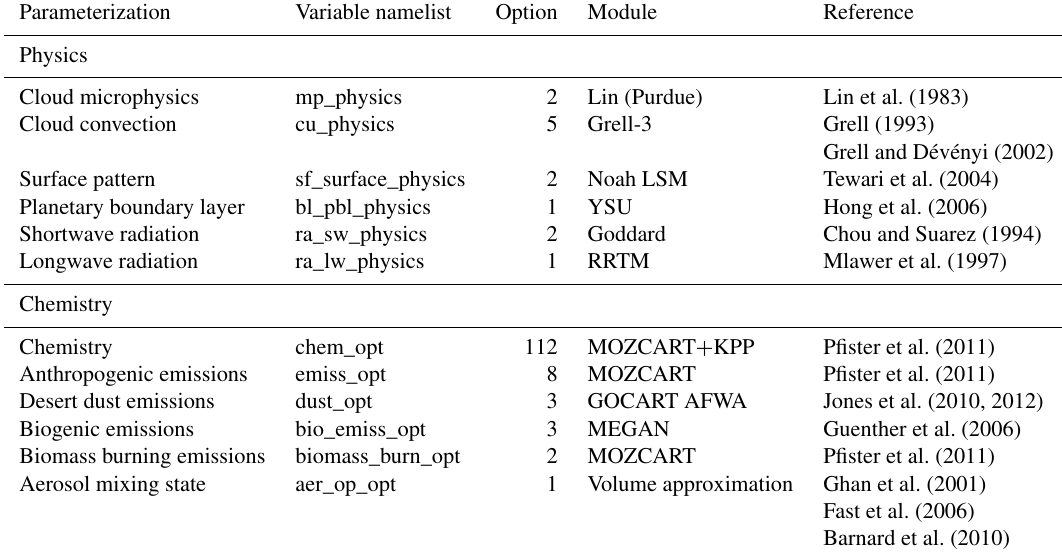
Table 1. WRF-Chem V3.9.1.1 main physico-chemical options selected for the study of the biomass burning aerosol optical properties and their climate forcing over the southeast Atlantic